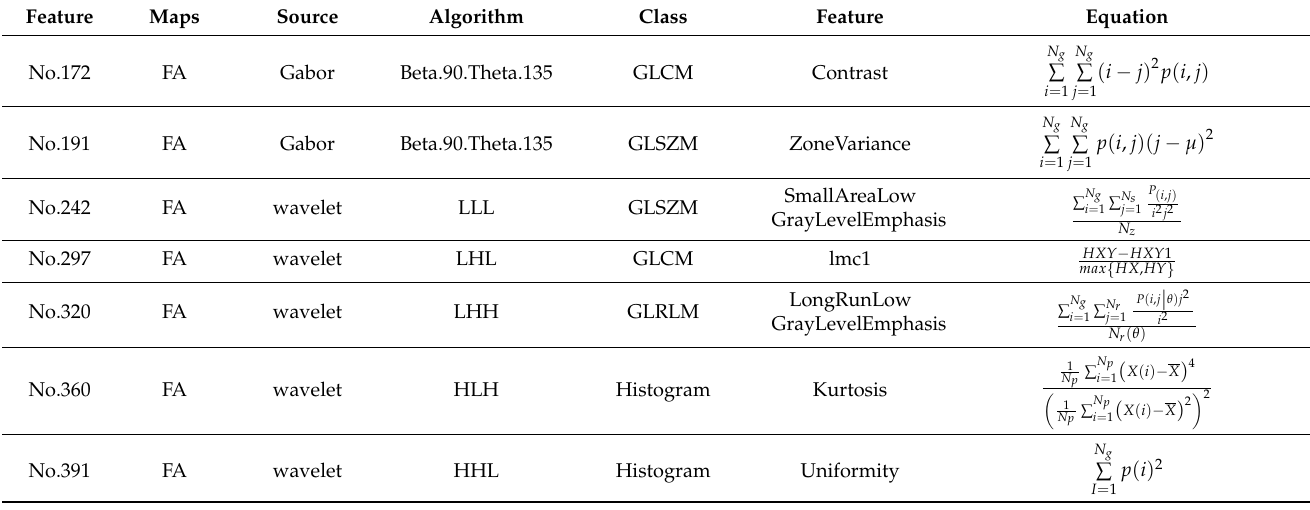
Table 2. List of maps, source (image form), algorithm of source, feature class, feature name, and formula of each selected radiomic feature.